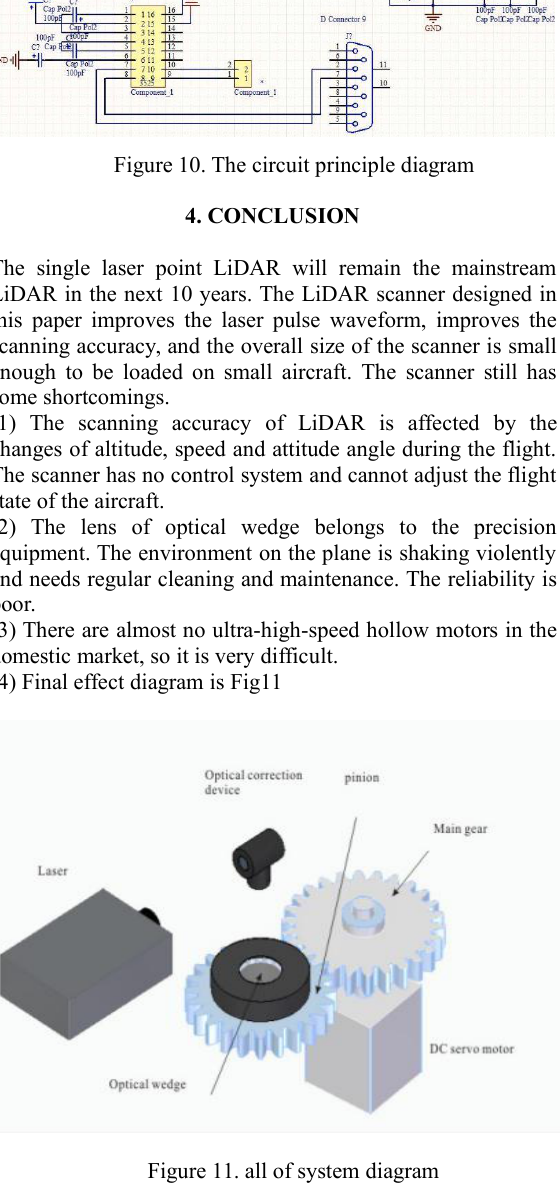
Figure 11. all of system